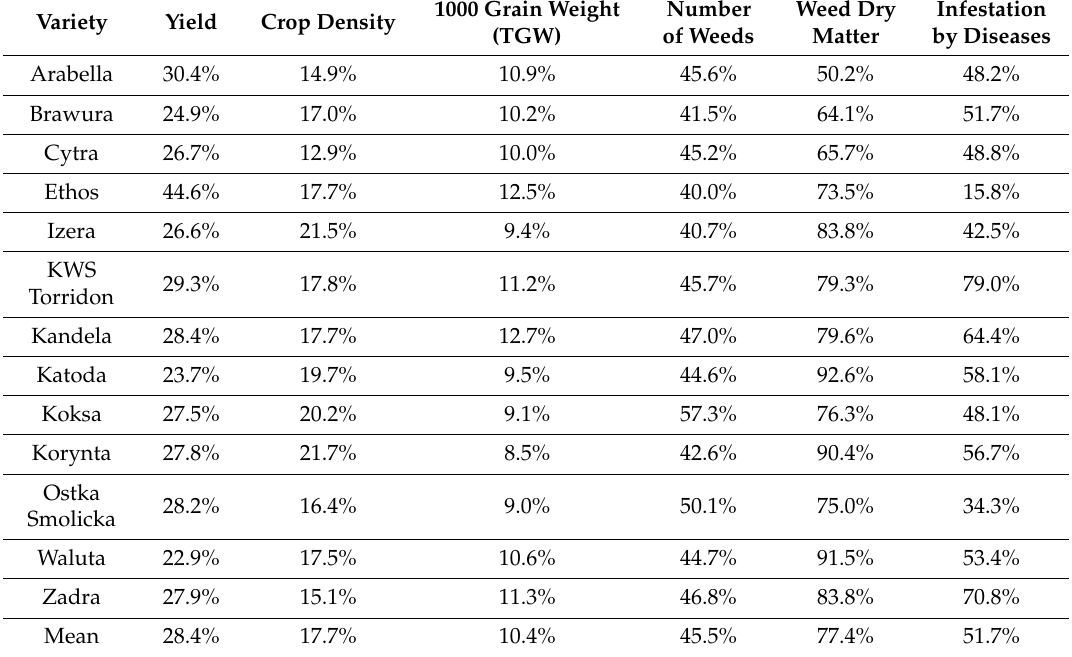
Table 3. Coe ffi cients of variation for grain yields and associated traits of spring wheat varieties from 3 years of research (2014–2016) and 3 experimental locations ( n = 36).